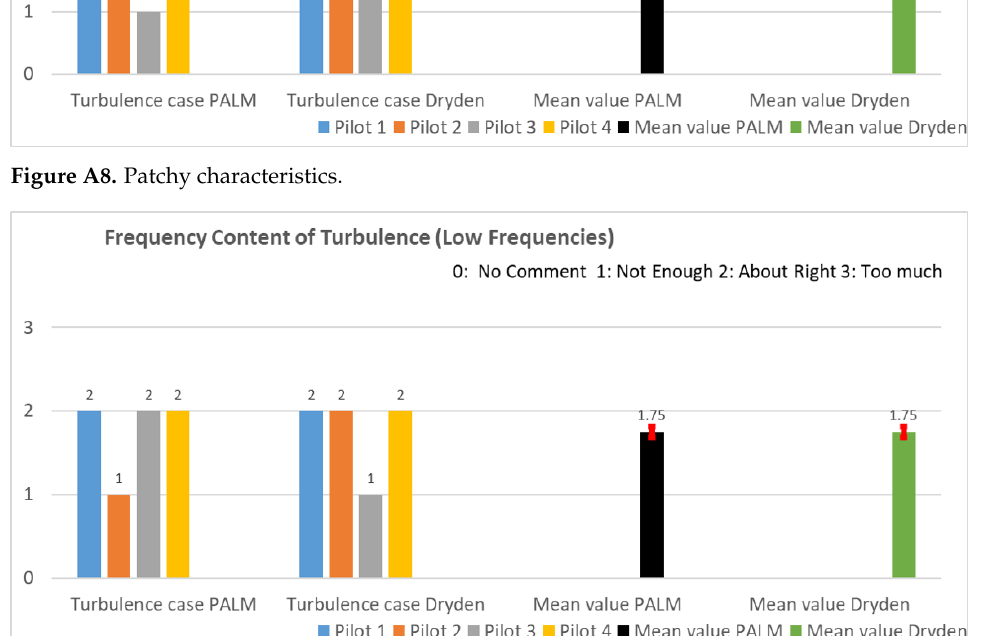
Figure A9. Frequency content of turbulence (low